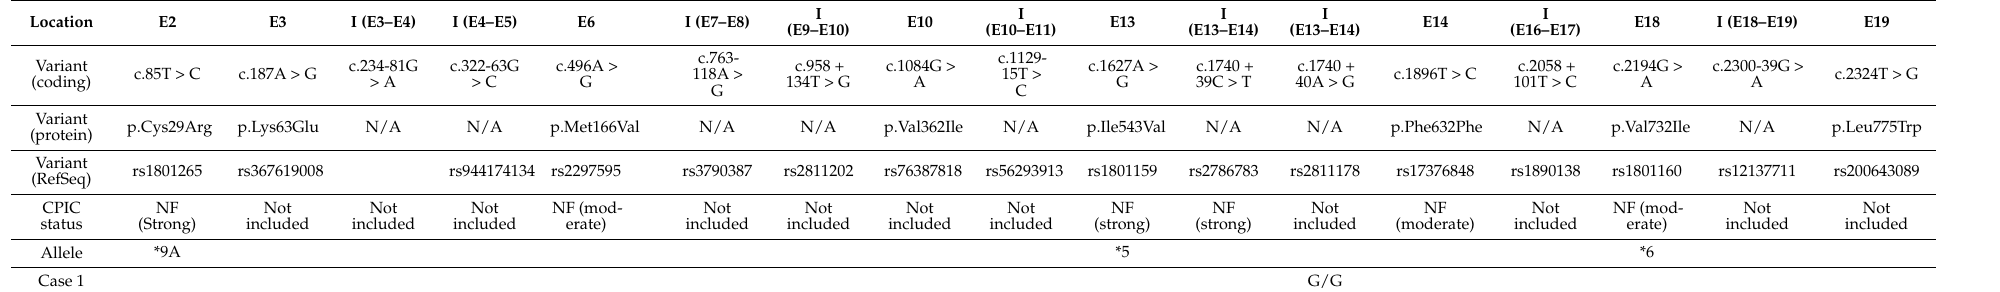
Table 3. Variants identified in all cases and controls in the present